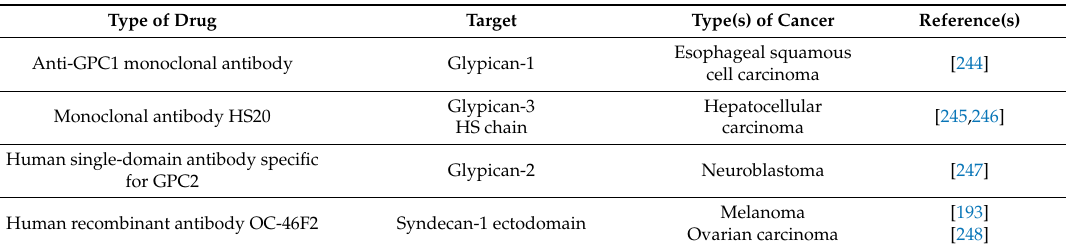
Table 4. Selected examples of HSPG targeting-based therapeutics for